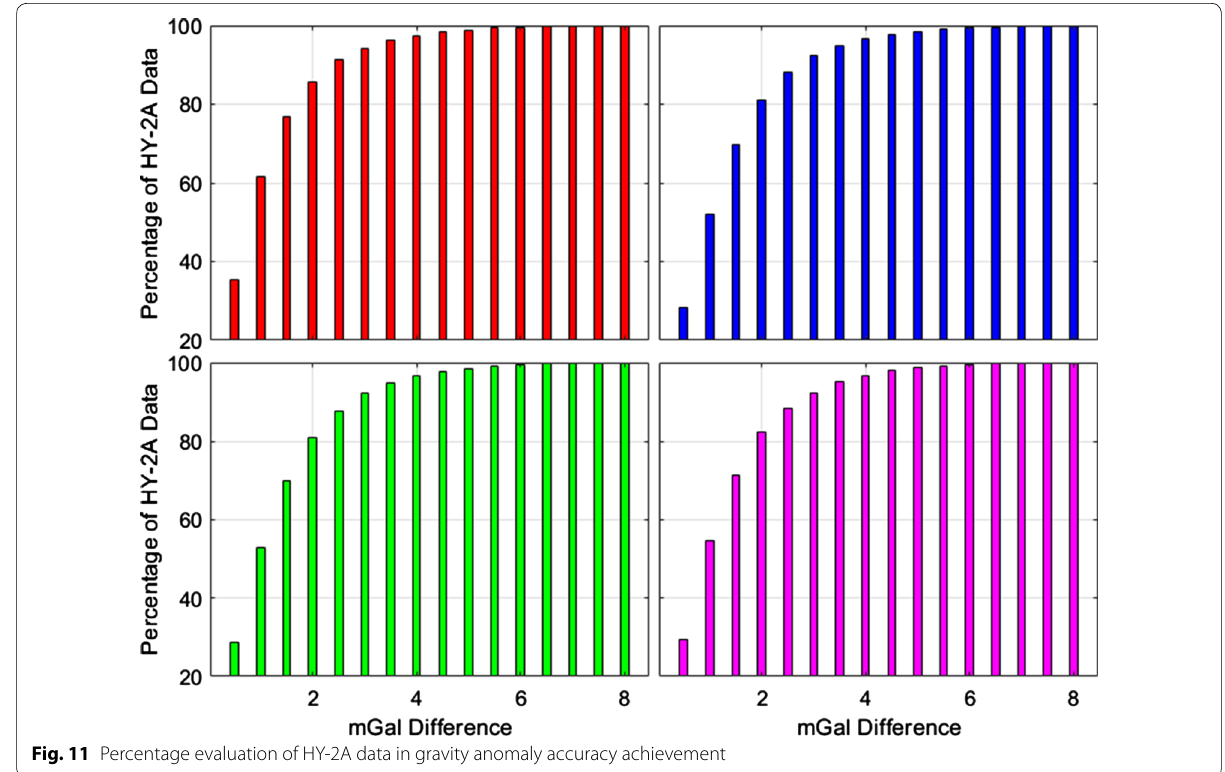
Fig. 11 Percentage evaluation of HY-2A data in gravity anomaly accuracy